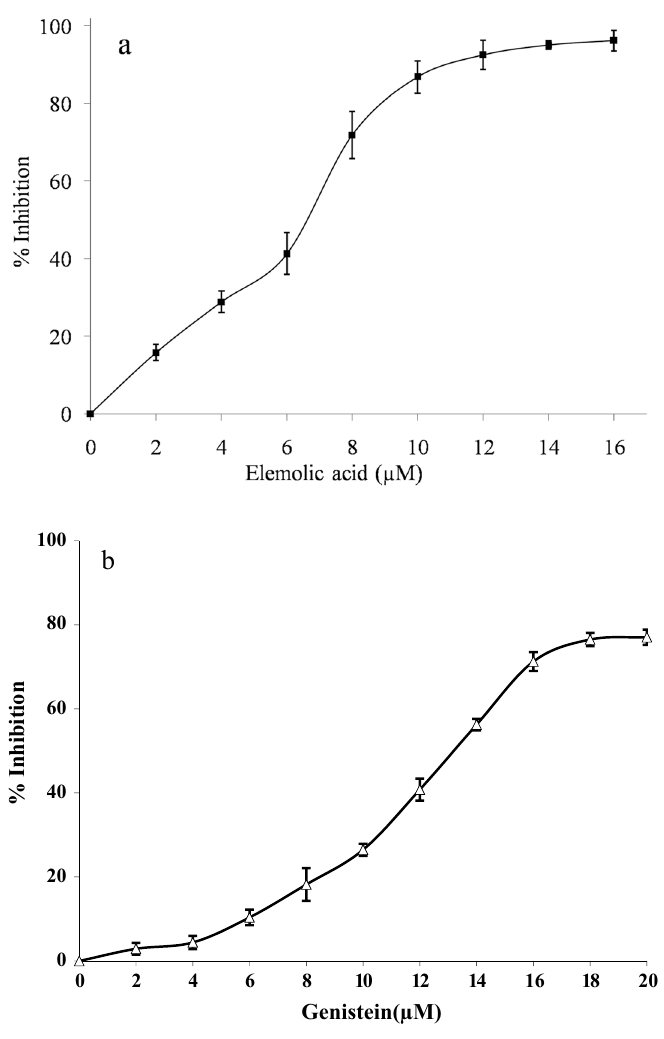
Figure 5. Inhibition of GIIA enzyme by elemolic acid ( a ) and genistein ( b ). Briefly, 350µL reaction mixture consists of 3.18 × 10 9 autoclaved E. coli cells, 5 mM calcium, and 100 mM Tris–HCl buffer pH 7.4, with GIIA and indicated concentration of inhibitors, incubated at 37 °C for 60 min. GIIA activity was measured by the radiation of 14 C using Quantulus 1220 liquid scintillation spectrometer (Perkin Elmer, USA). GIIA inhibition was noted as a percentage of control. The data are represents mean ± SD (n = 3).